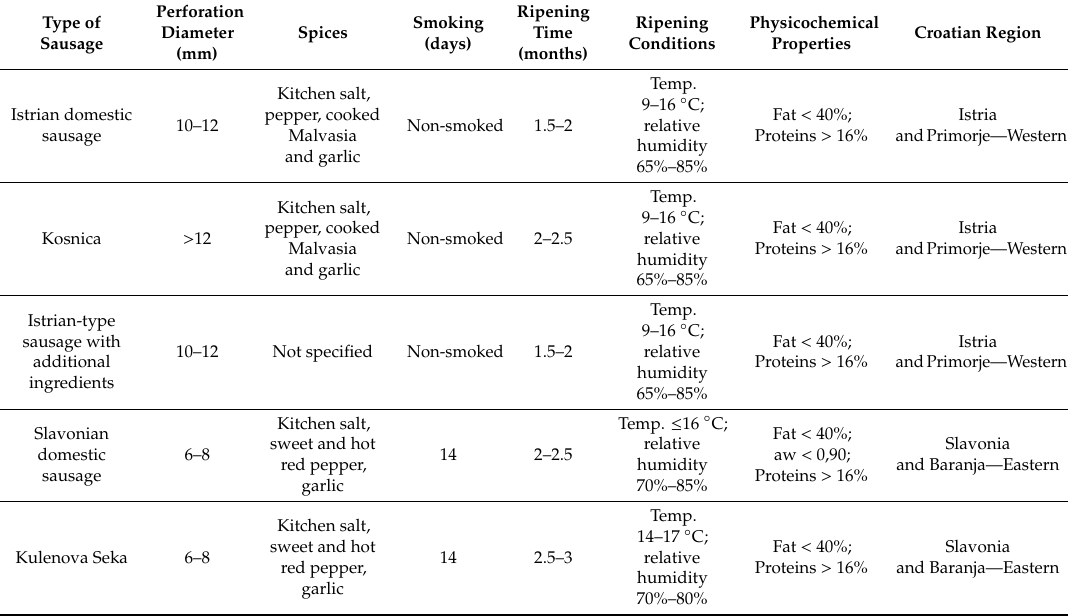
Table 1. Specificity of the production technology and properties of the analyzed dry-fermented sausages